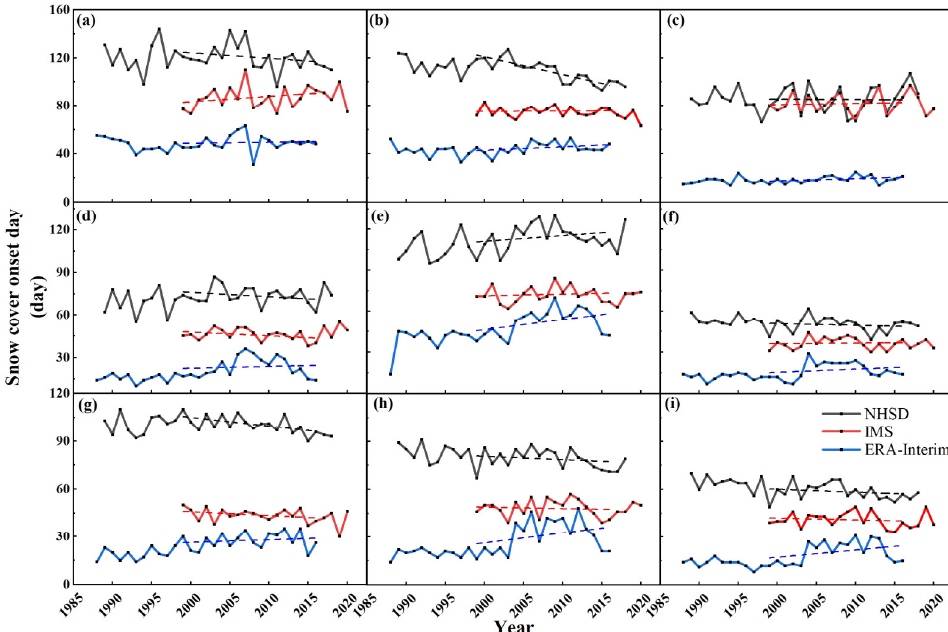
Figure 12. Comparison of the SCOD derived from NHSD, IMS, and ERA-Interim in typical areas. The typical areas are ( a ) the Alps, ( b ) the Rocky Mountains, ( c ) the Qinghai–Tibet Plateau, ( d ) Alaska, ( e ) the Eastern European Plain, ( f ) the Eastern Siberian Mountains, ( g ) Northern Canada, ( h ) the West Siberian Plain, and ( i ) the Central Siberian